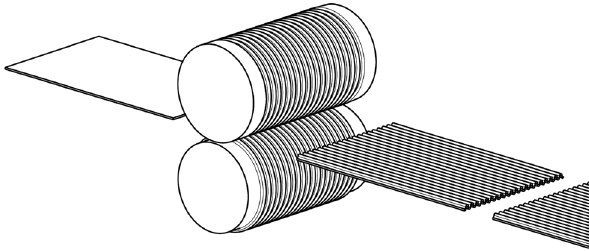
Figure 6 Basic principle of microstructuring metal strips by using roll embossing